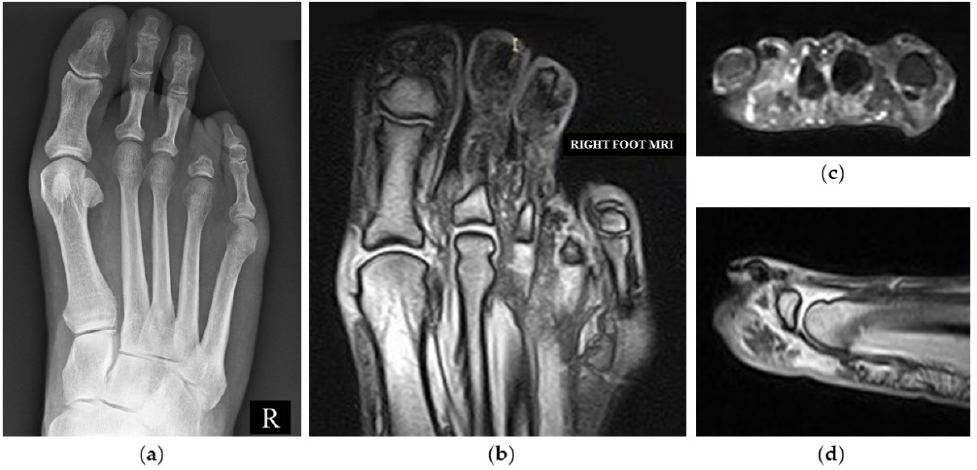
Figure 4. Weightbearing X-ray AP image of the right foot showing the fourth toe amputation at the level of the base of the P1 after surgery ( a ). MRI of the right forefoot performed at 6 months from the amputation, showing flattening of the plantar arch, signs of overload of the fourth metatarsal head and persistence of suprafascial plantar edema ( b ) coronal; ( c ) axial; ( d ) sagittal view.